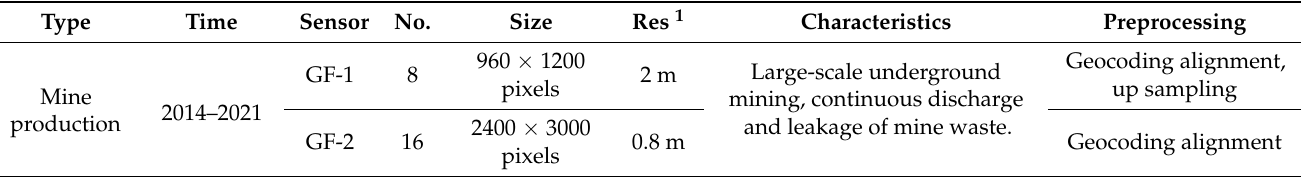
Table 3. Overview of the experimental data of GF-1 and GF-2